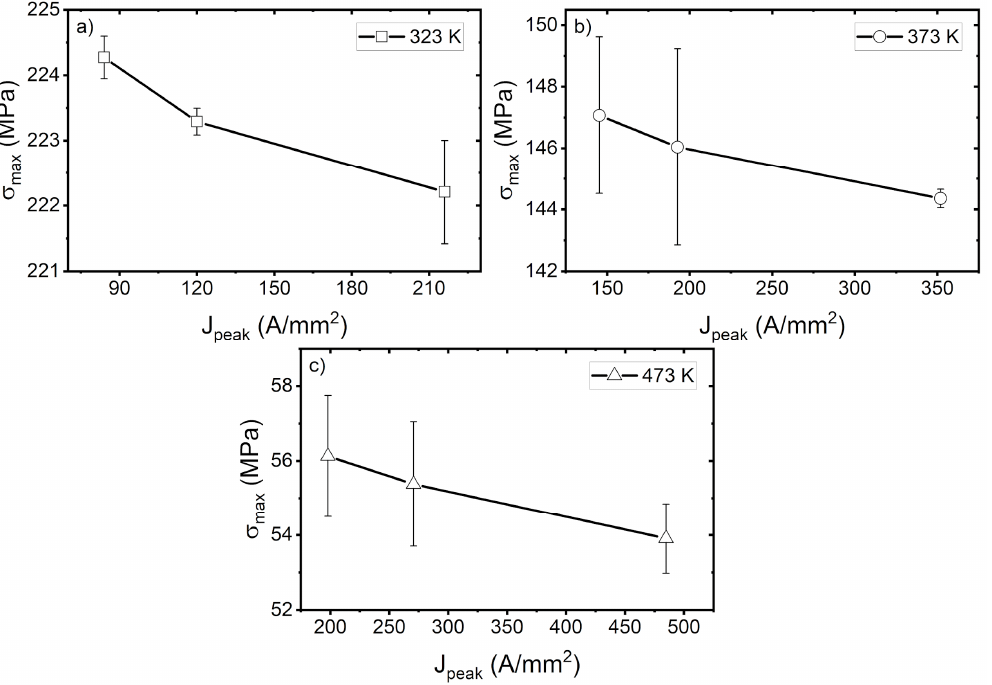
Figure 8. Ultimate tensile strength at various peak current densities at ( a ) 323 K, ( b ) 373 K, and ( c ) 473 K.